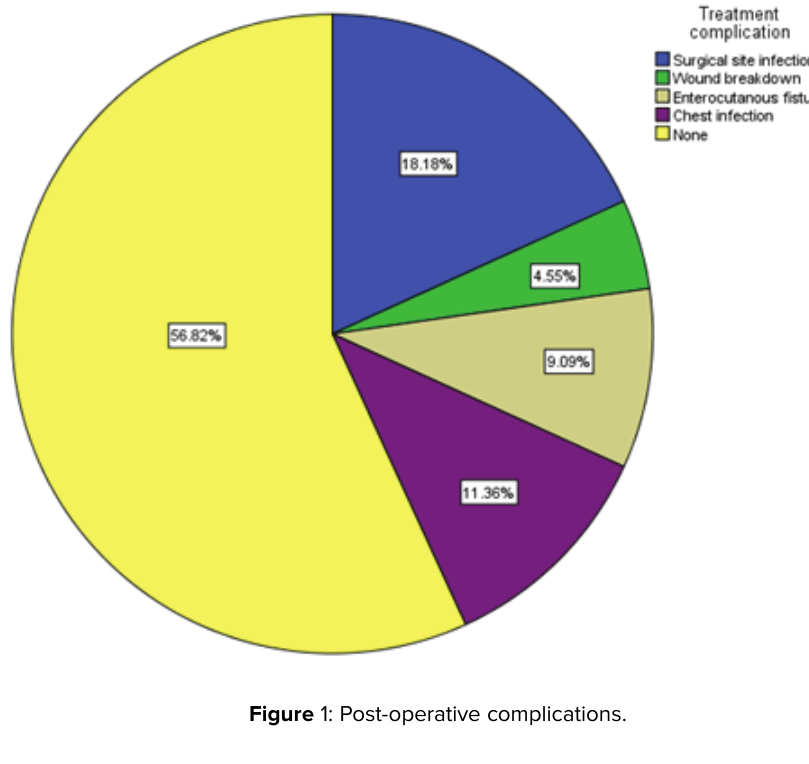
Figure 1: Post-operative